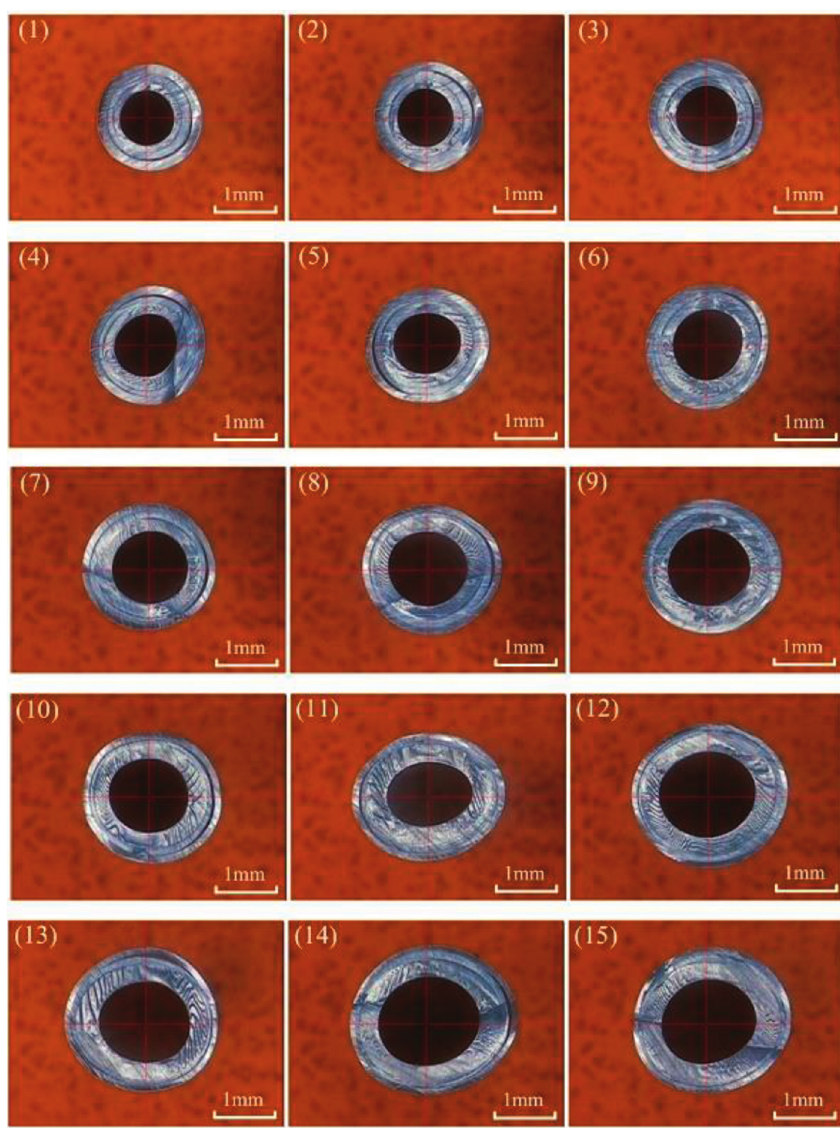
Figure 13: Graphics of cross sections of catheters at different screw speeds ( N N n 4 � 12 r/min, (e) N n 5 � 14 r/min, (f) N n 6 � 16 r/min, (g) N n 7 � 18 r/min, (h) N n 8 � 20 r/min, (i) N n 9 � 22 r/min, (j) N n 10 � 24 r/min, (k) N n 11 � 26 r/min, (l) N n 12 � 28 r/min, (m) N n 13 � 30 r/min, (n) N n 14 � 32 r/min, and (o) N n 15 � 34